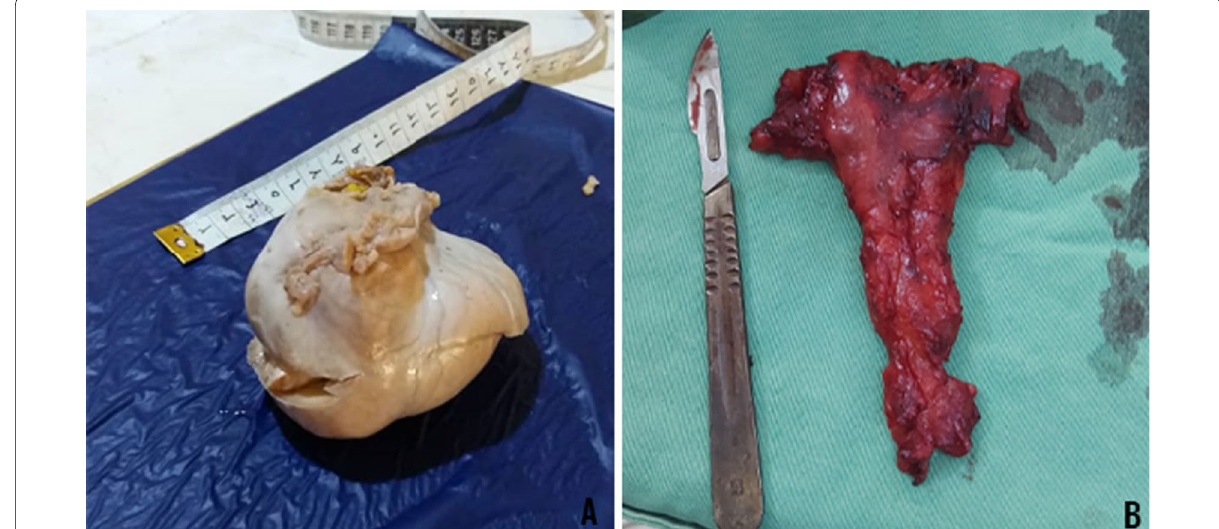
Fig.4 A Mass of the well-circumscribed testis, with smooth gray mass, and attached tube-like structure. B Rudimentary uterus